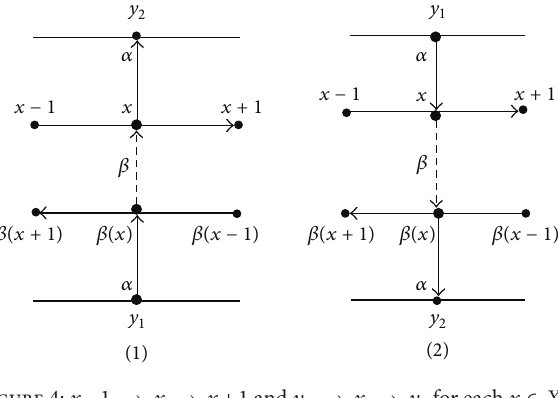
Figure 4: 𝑥−1 → 𝑥 → 𝑥+1 and 𝑦 1 → 𝑥 → 𝑦 2 for each 𝑥 ∈ 𝑋 + .